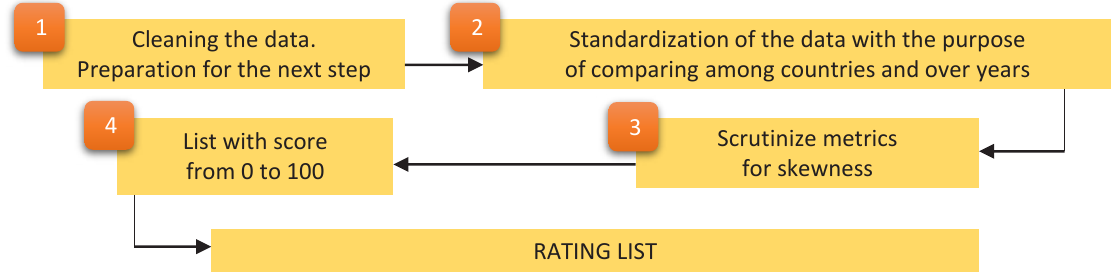
Figure 1. The algorithm of calculation the Environmental Performance Index